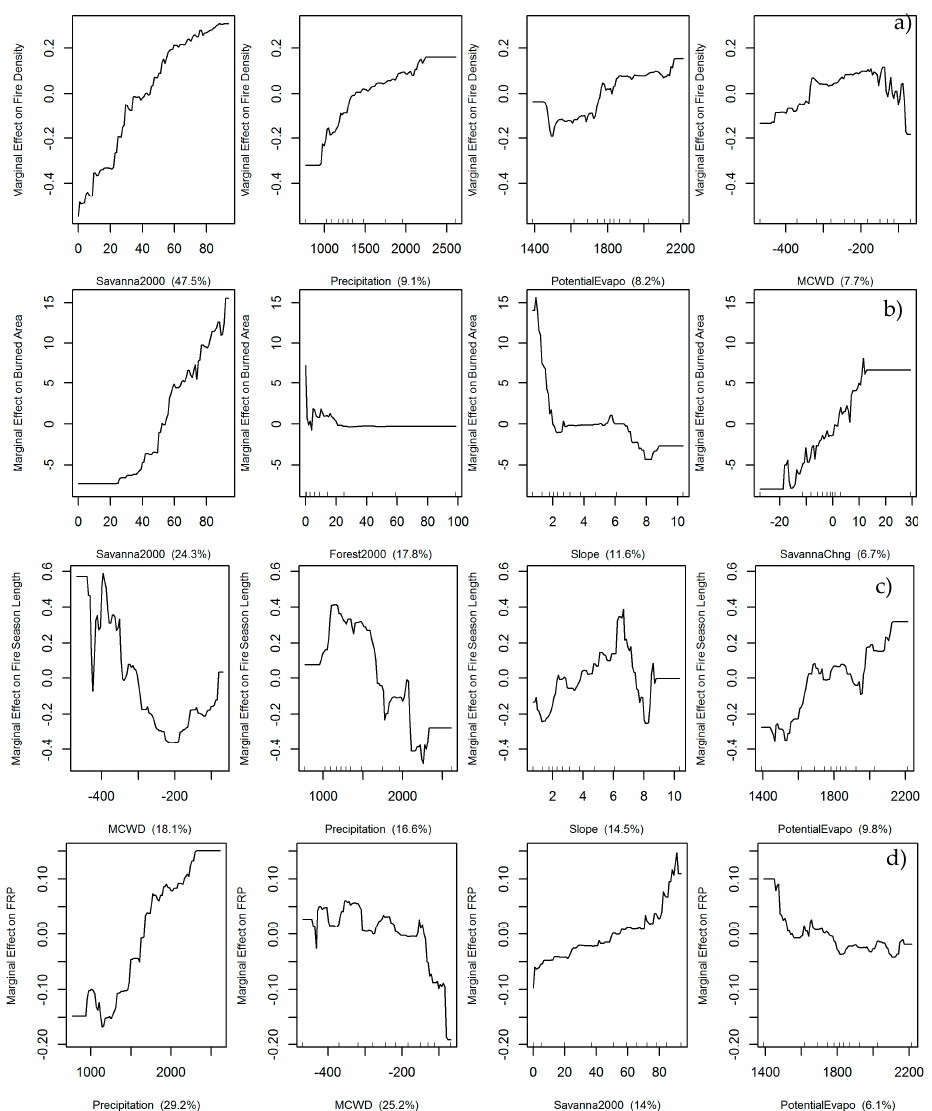
Figure 9. Partial dependence plots of the top four (4) predictors from the BRT model for each fire regime component: ( a ) active fire density; ( b ) percent burned area; ( c ) fire season length; ( d ) fire radiative power. The plots represent the effect of each predictor on fire activity after considering the average effect of all predictors in the model. Abbreviations of predictor variables and their corresponding full names are described in Table 1.